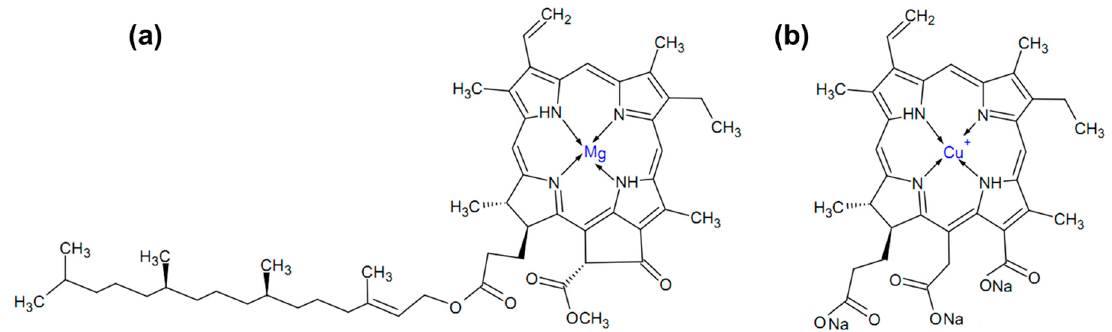
Figure 1. Chemical structure of chlorophyll ( a ) and chlorophyllin ( b ).